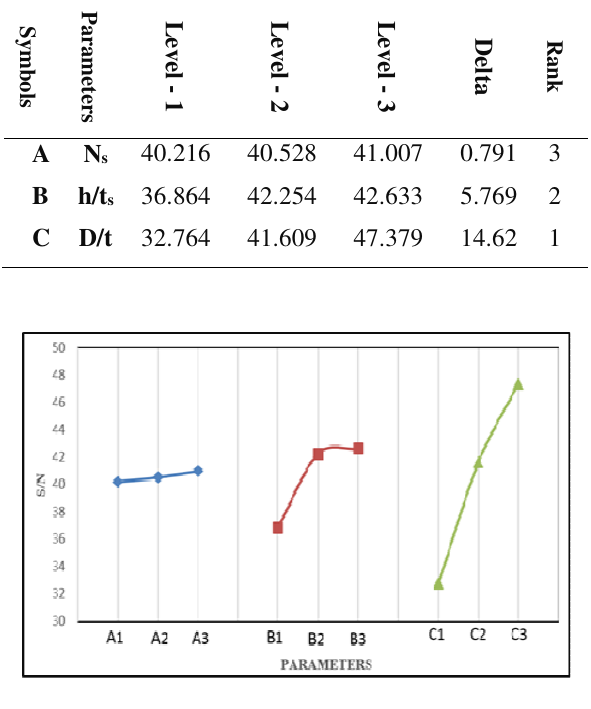
results indicate the importance and contribution of parameters as a percentage. The D/t ratio has the highest contribution (80.814%) and the lowest and approximately no effect is number of stiffeners (0.133%).